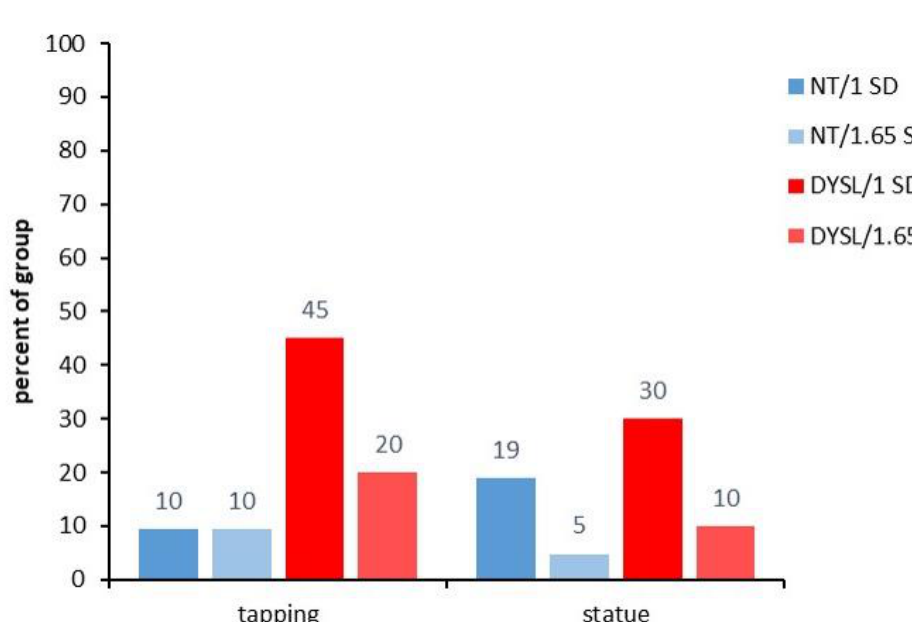
Figure 5. Deviating performance/cerebellar subtests. NT: neurotypical normal reading children, DYSL: children with dyslexia.